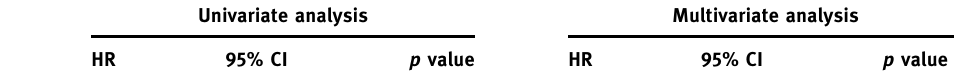
Table 2: Univariate and multivariate analyses of 5 - year DFS rate for patients with stage I